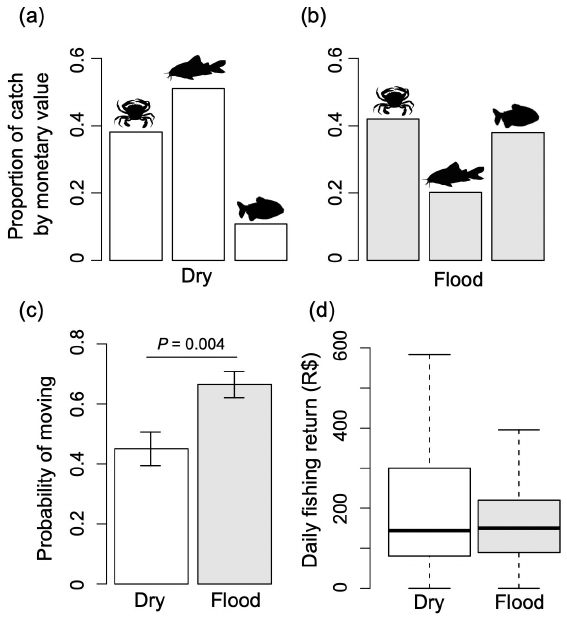
Fig. 3 . Seasonal changes in fishing practices and return rates. (a-b) Catch composition in the dry and flood season, divided into three main categories (from left to right): bait,